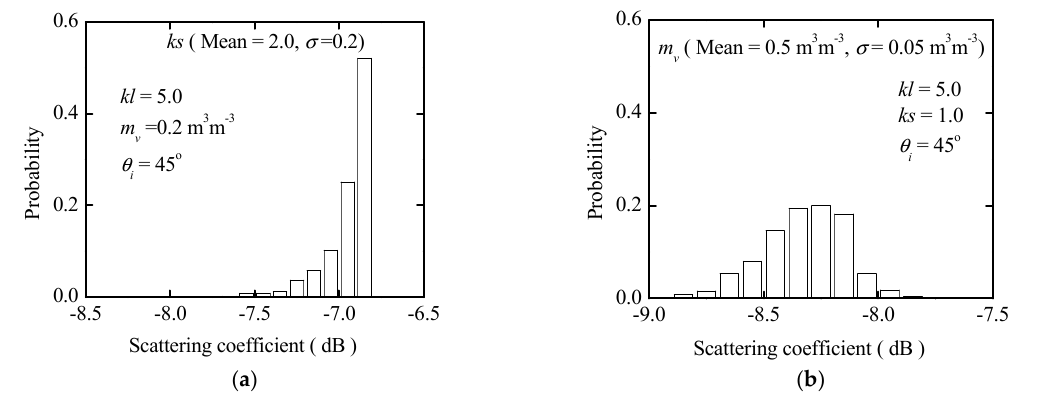
Figure 5. Probability distribution response of backscattering for rough surface with: ( a ) great roughness; and ( b ) high water content. and ( b ) high water